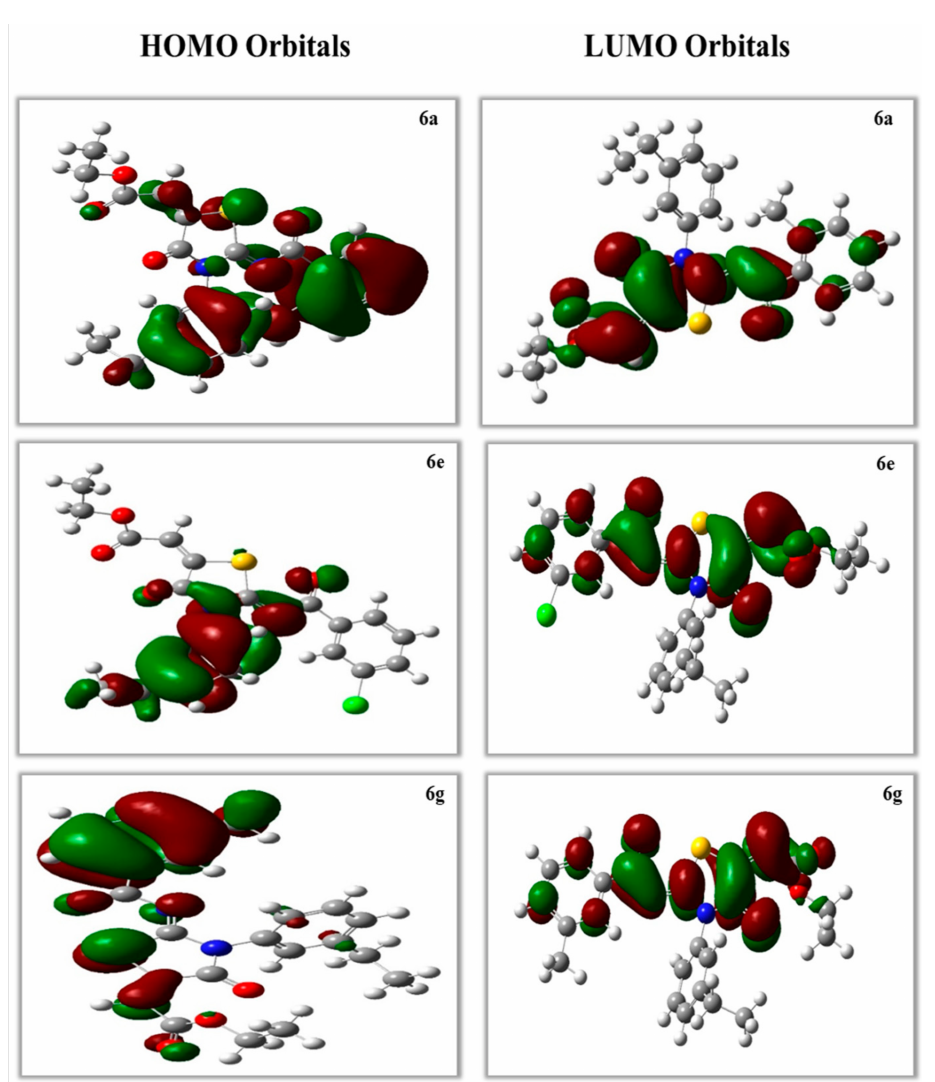
Figure 5. Illustration of HOMO/LUMO orbitals of compound 6a , 6e , and 6g . Table 2. Quantum chemical descriptors of synthesized derivatives ( 6a – 6j